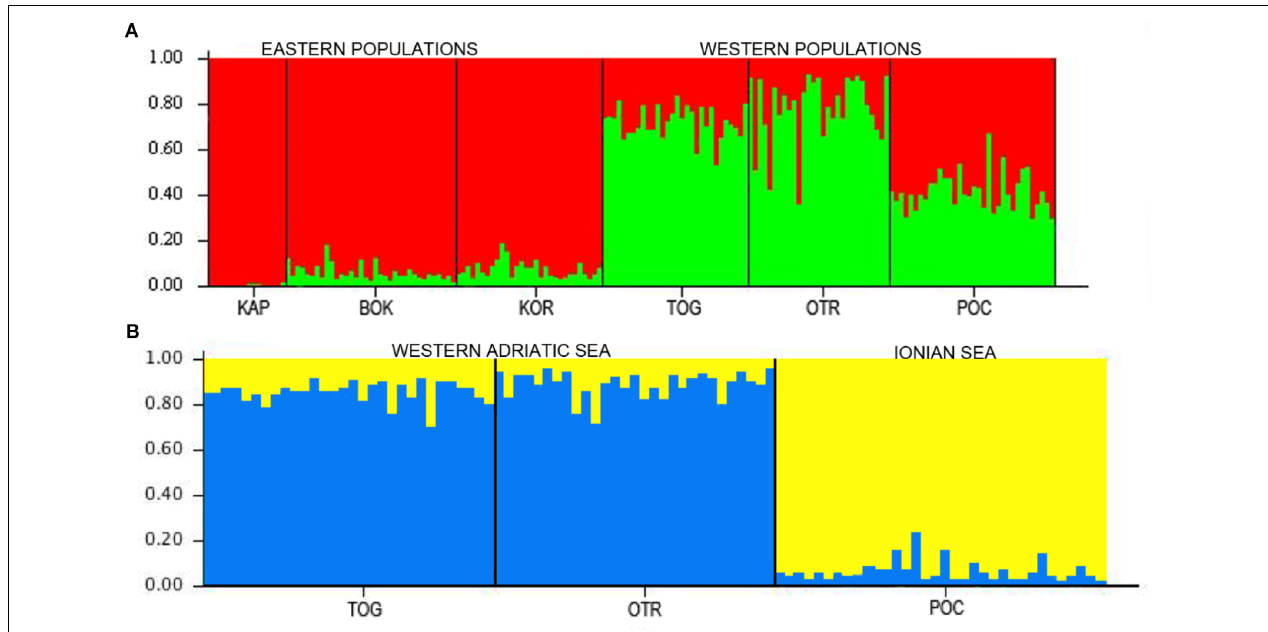
FIGURE 2 | (A) STRUCTURE results for the six locations in the Adriatic and Ionian seas ( K = 2). (B) STRUCTURE results for the three west locations in the Adriatic and Ionian seas ( K = 2).